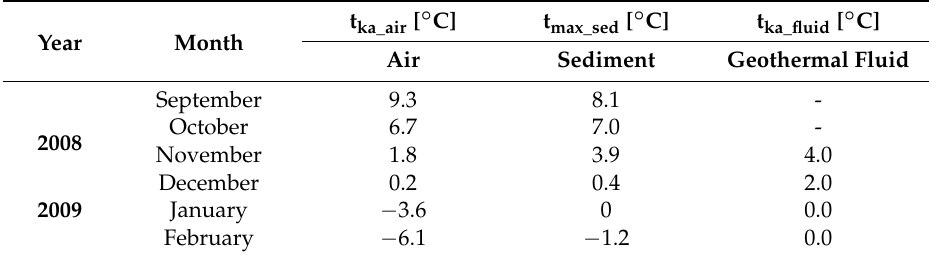
Table 1. The monthly mean air temperatures (t ka_air ) [24] and the monthly maximum sediment temperatures (t max_sed ) [22] and the geothermal fluid temperatures (t ka_fluid ) in Vaasa during the measurement period in 2008–2009. t ka_air [°C] Year Month Year Month Sediment Geothermal Fluid